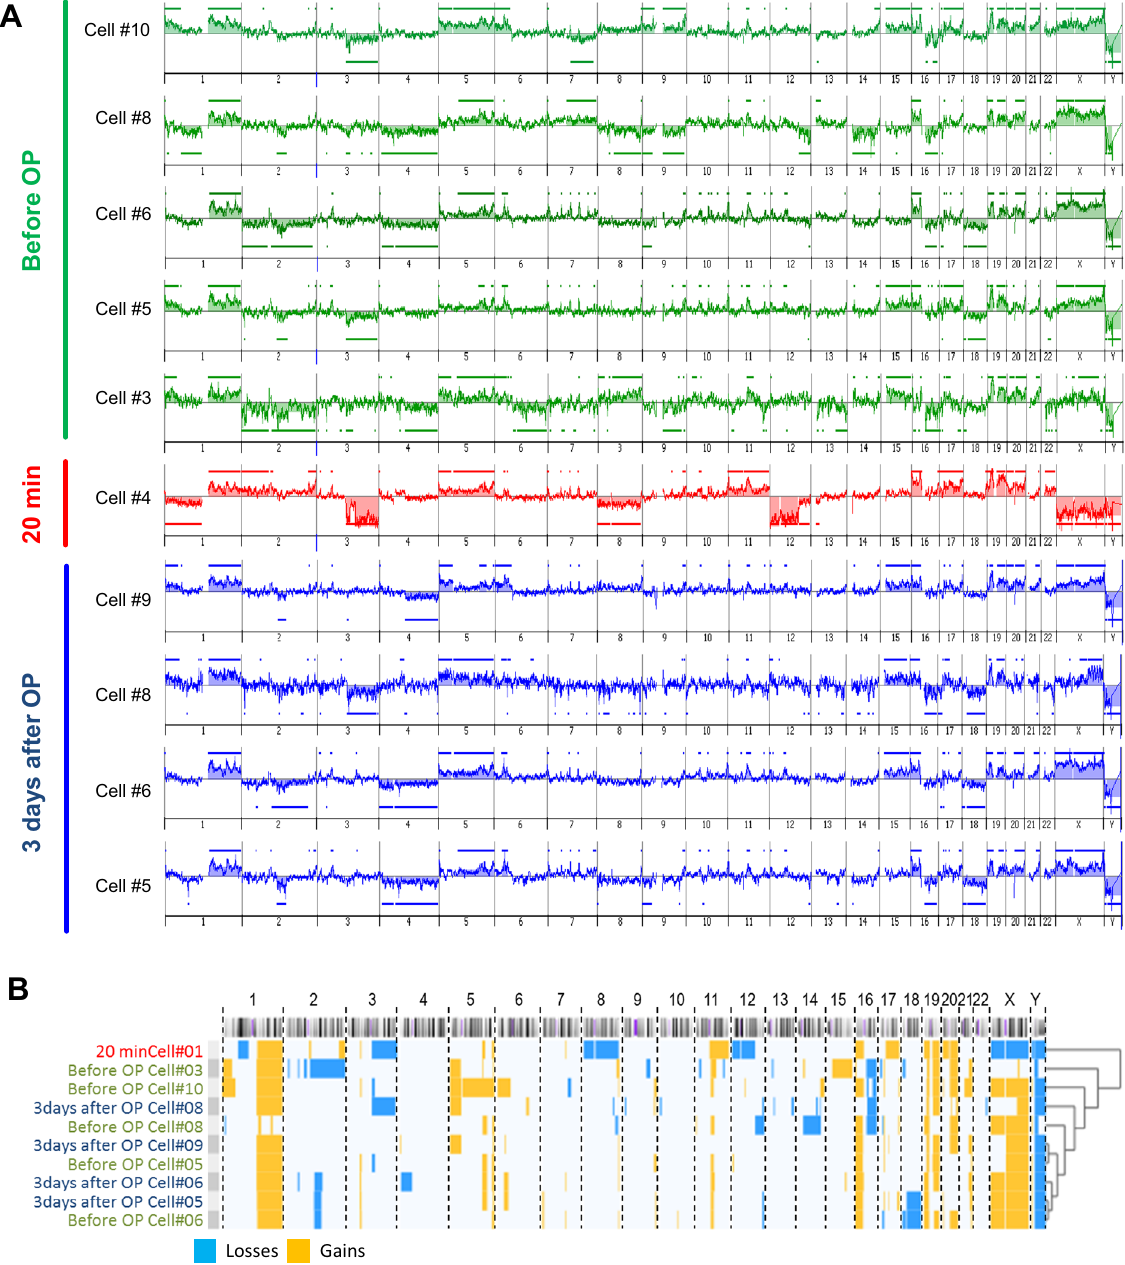
Figure 3. ( A ) Genomic landscape, analysed by array comparative genomic hybridization (aCGH), of individually picked CTCs at the three different time-points before and after cement augmentation. Genomic losses are shown below and gains with bars above. ( B ) Hierarchical clustering of genomic alterations demonstrate a distinct molecular of the mechanically released CTC at 20 minutes after cement